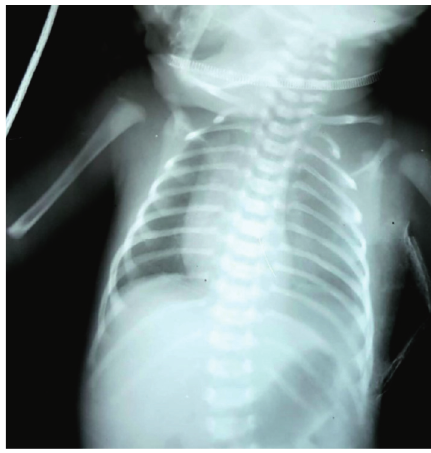
Figure 1: Left-sided pleural effusion of case 1.